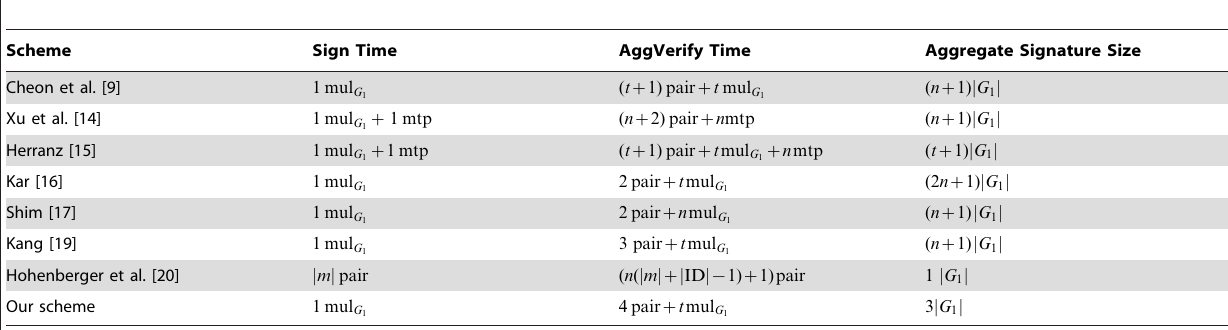
Table 1. Comparisons of computation cost and aggregate signature size.